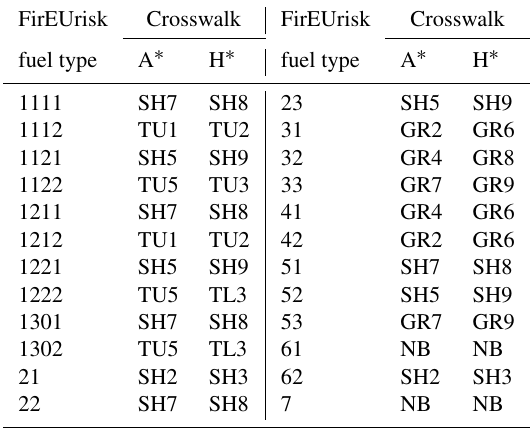
Table 5. Suggested attribution of the first-level FirEUrisk fuel types to the FBFM standard fuel models in